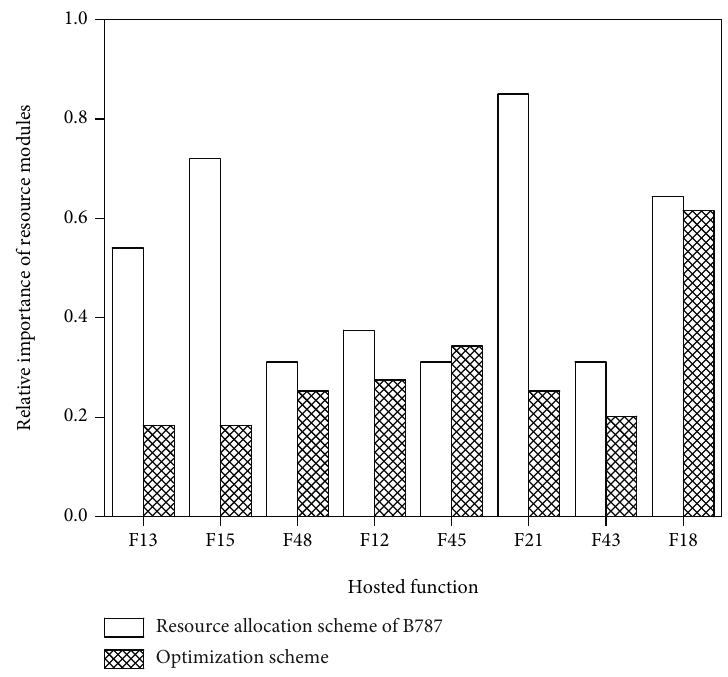
Figure 8: Relative importance for resource module servicing key function.